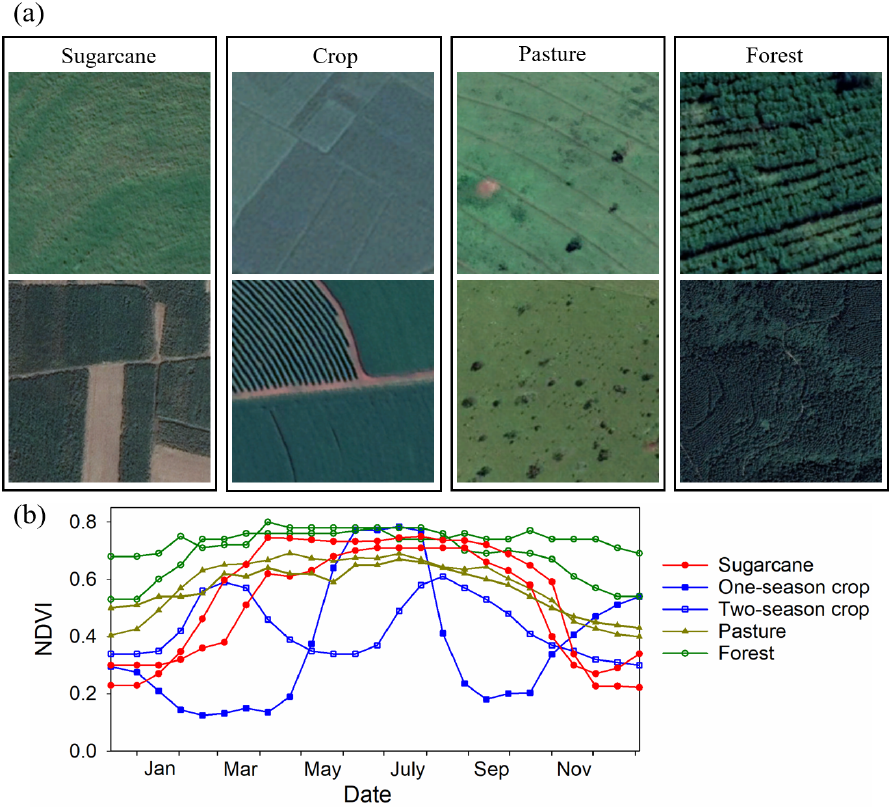
Figure 3. Examples of the (a) colour and textures on the high-resolution images from © Google Earth and (b) time series of NDVI for different vegetation.